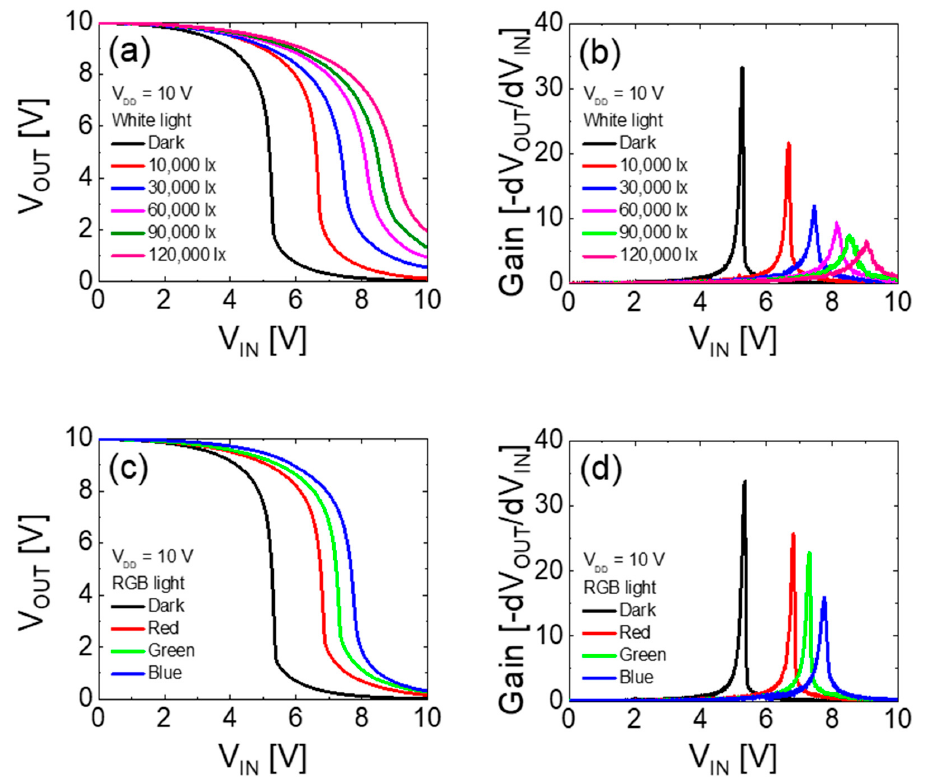
Figure 7. ( a ) voltage transfer characteristic (VTC) and ( b ) static voltage gain curves of the vertically stacked complementary inverter under white light illumination with different intensities. ( c ) VTC and ( d ) static voltage gain curves of the inverter under RGB light illumination. The VTCs and corresponding voltage gain curves were measured at V DD = 10 V. The fixed RGB light intensity was ~6.5 mW/cm 2 .